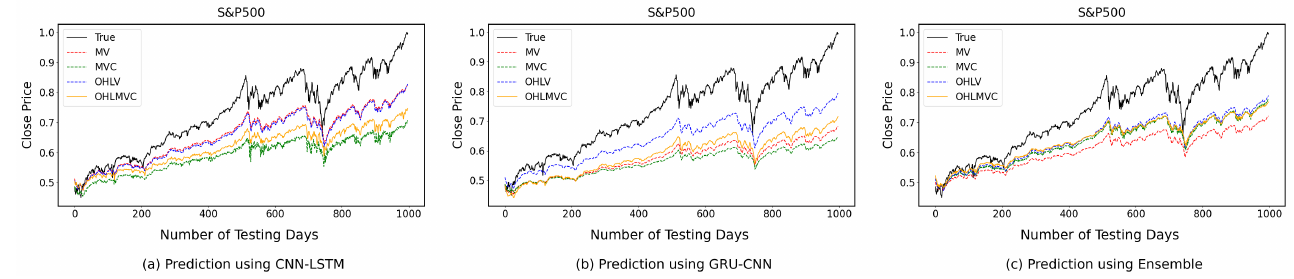
Figure 14. Comparison of true and predicted close prices of the S&P500 index between different input features for five-time-step prediction over the period from 1 January 2000 through 31 December